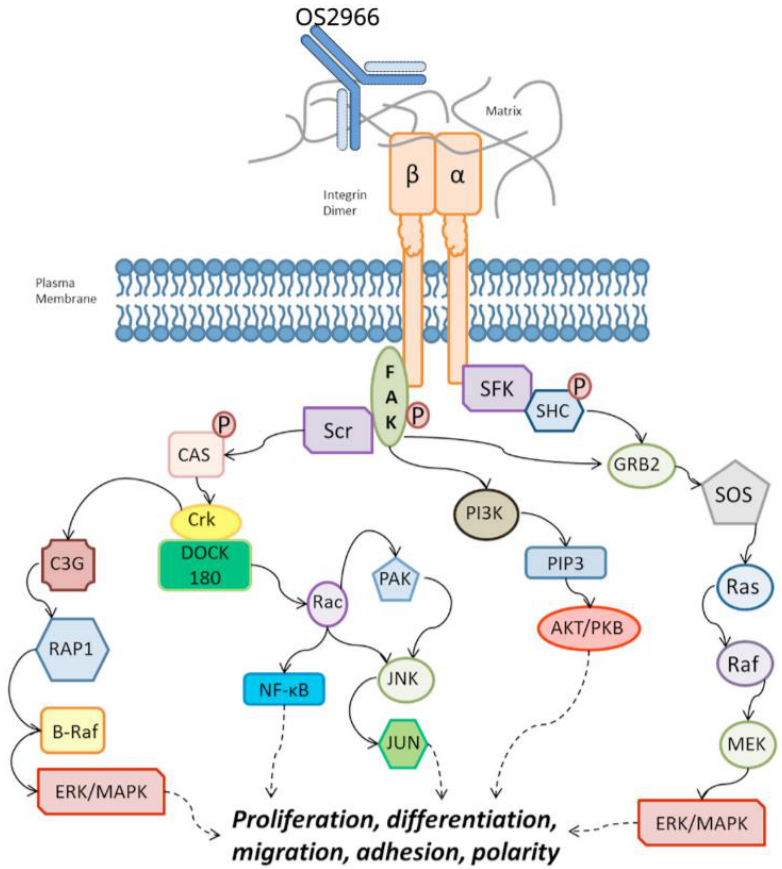
Figure 1. This illustrates the various pathways downstream of the β-1 integrin/CD29 receptor. Critical pathways that are governed by CD29 (β1 integrin subunit) signaling include the hallmarks of cancer, biological capabilities acquired during the multistep development of human tumors: growth factor signaling (survival/proliferation), invasion and metastasis (cell motility), angiogene- ventional therapy (increased survival, epithelial-to-mesenchymal transition, enhanced stress re- (mAb). Adapted with permission from [11], Frontiers Media S.A.,